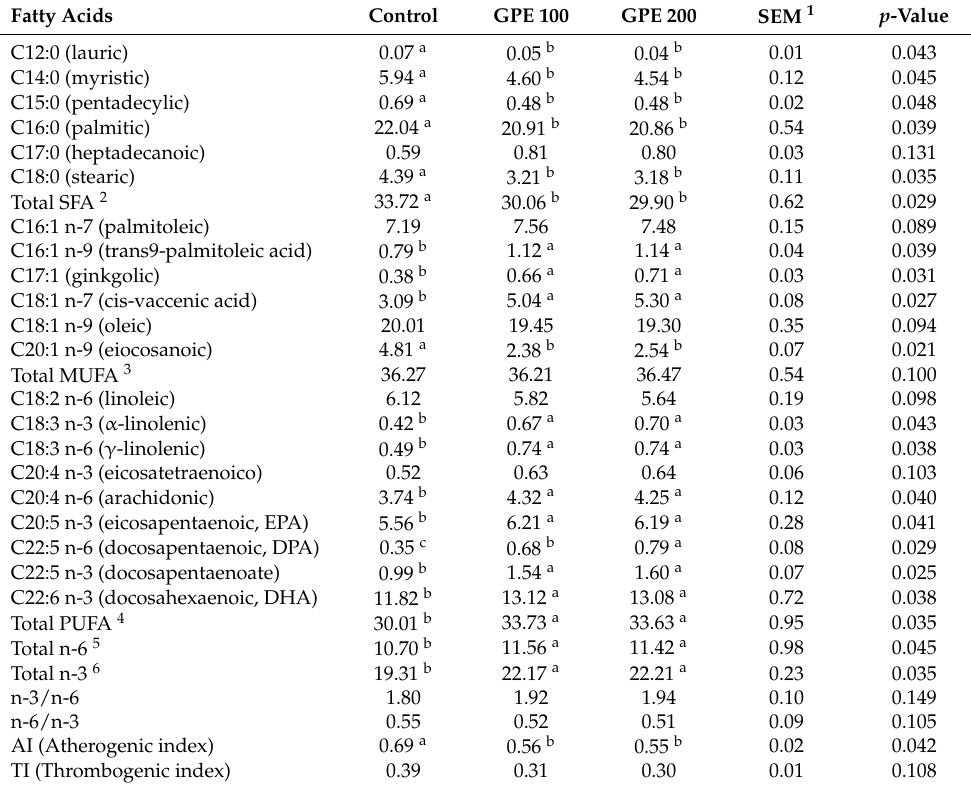
Table 5. Fatty acid profile of fillets from European sea bass fed diets with two levels of red grape extracts (% total fatty acids methyl